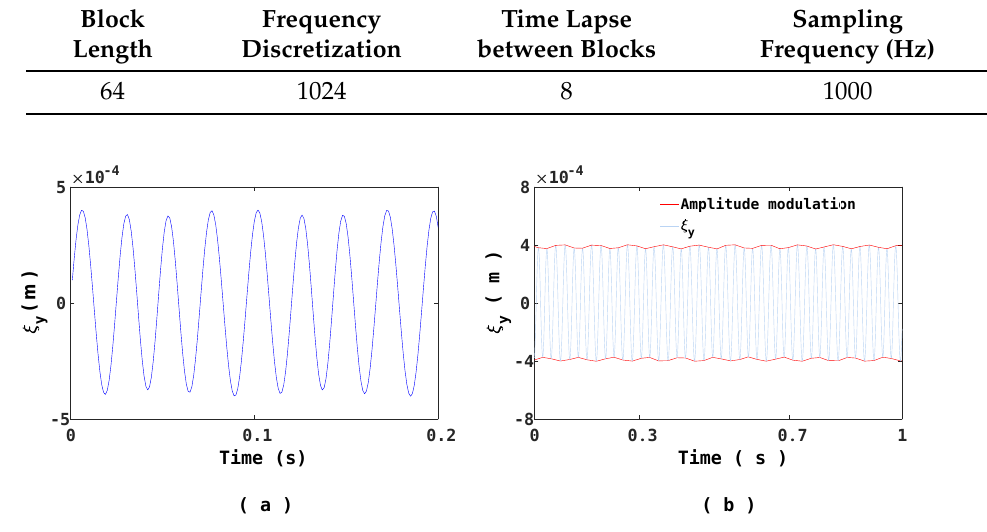
Figure 10. ( a ) Heave displacement ξ y of the hydrofoil, t ∈ [ 0,0.2 ] . ( b ) Heave displacement ξ y of the hydrofoil over a long period time, t ∈ [ 0,1 ] .